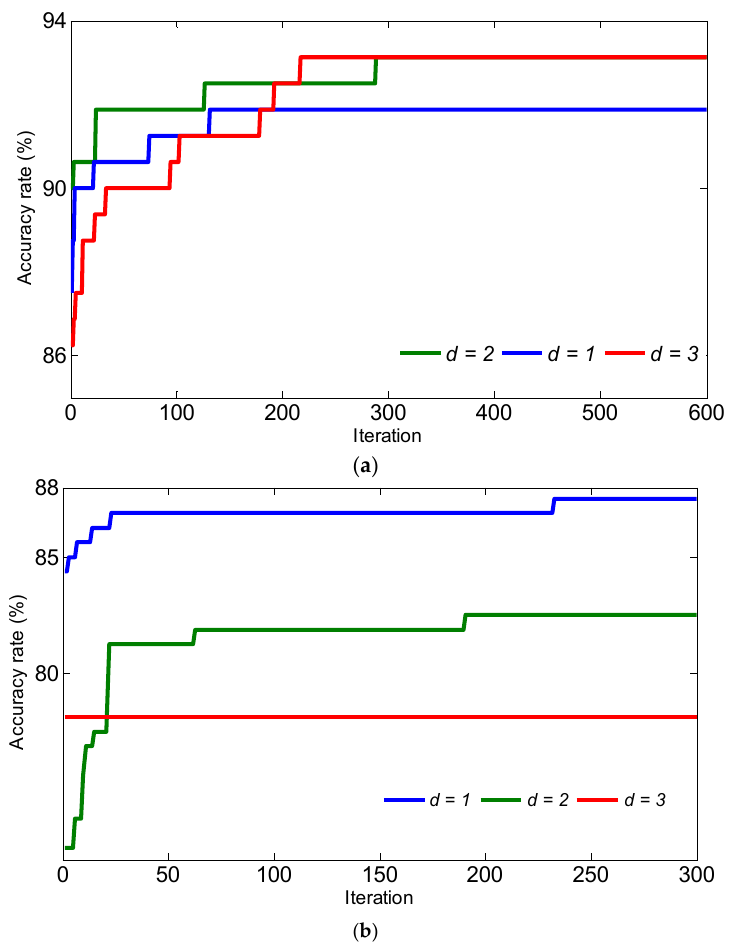
Figure 7. SVM-BA classifier evolution during the optimization process: ( a ) DGA in percentage; ( b ) DGA in ppm.